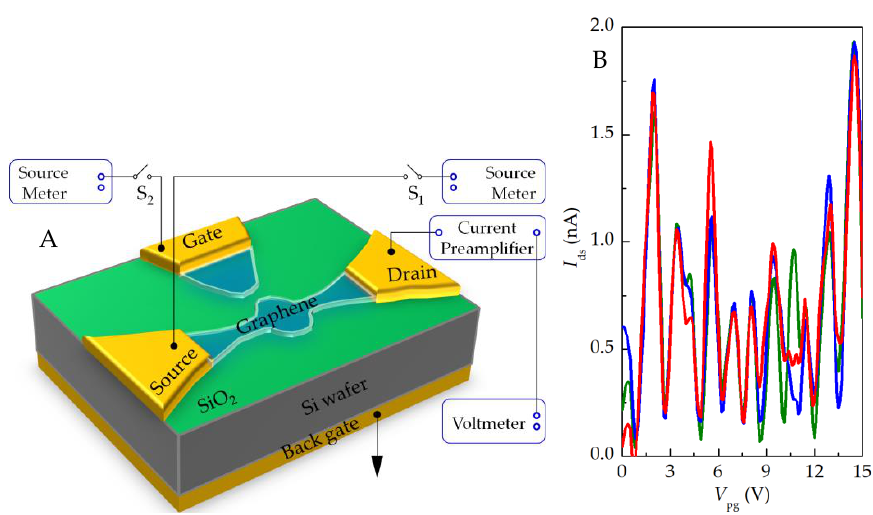
Figure 5. ( A ) Circuit diagram of plunger gate regulation test; ( B ) plunger gate regulation curve under certain source – drain bias voltage. The different color curves of red, green and blue represent the test curves obtained by different scanning, and the data repeatability is good.